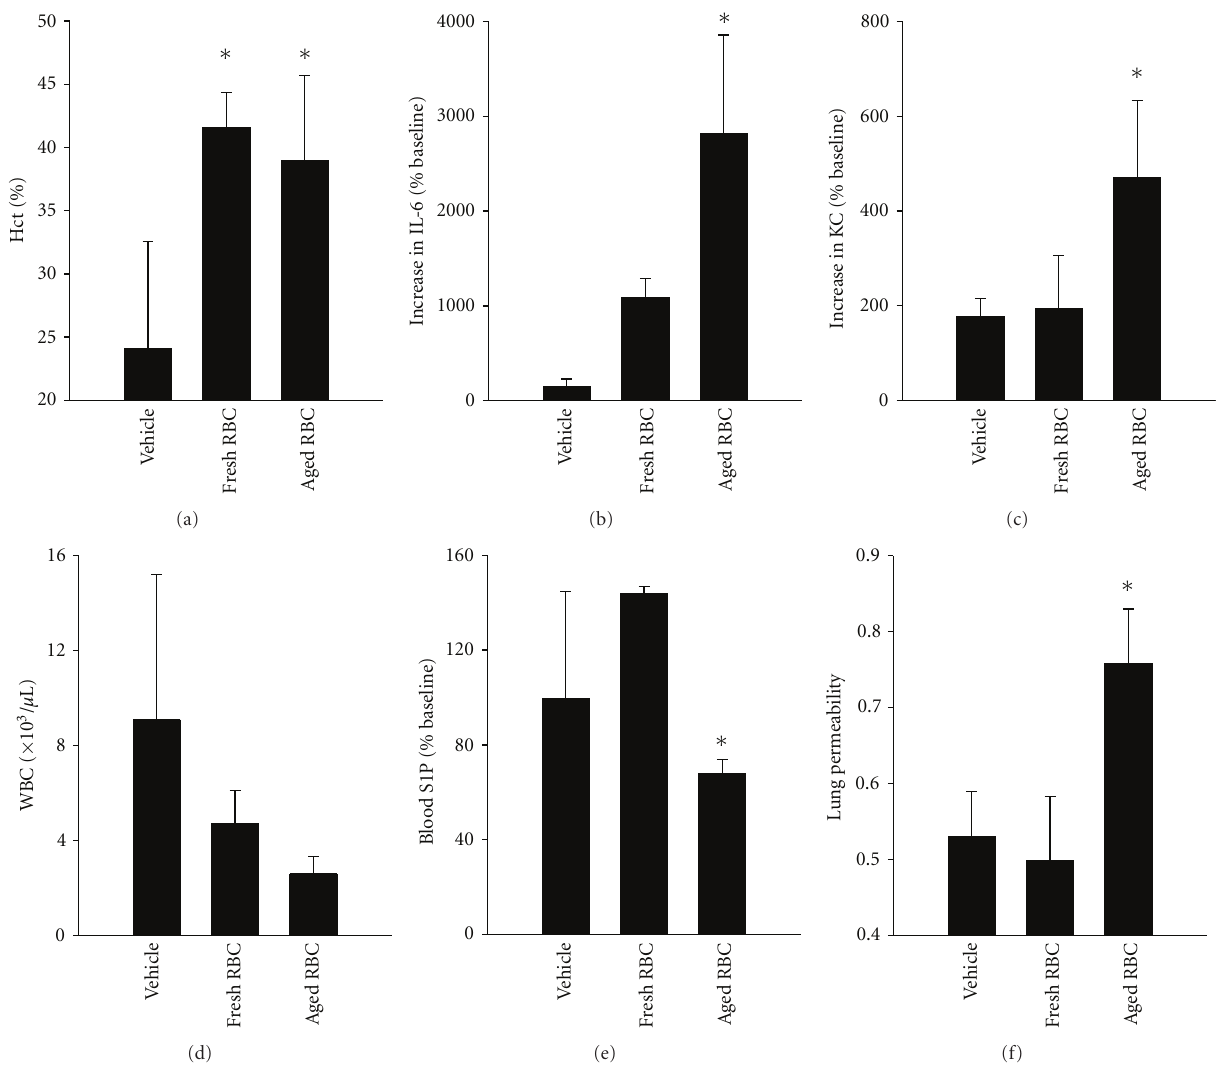
Figure 2: E ff ect of transfusion of fresh and aged RBC on systemic inflammation response and lung endothelial permeability. Twenty-four hours after major blood loss (0.02mL/gm), mice were administered 0.3 mL of PBS (“vehicle”), freshly isolated RBC at 50% Hct (“fresh RBC”), or RBC stored for > 14 days (“aged RBC”) at 50% Hct. Fortyeight hours after initial blood loss, (a) Hct, (b) plasma Il-6, (c) plasma KC, (d) white blood cell count (WBC), (e) blood S1P, and (f) lung endothelial permeability were measured. IL-6, KC, and S1P are reported as % of baseline (time 0). Results were analyzed by one-way ANOVA (Bonferroni correction), ∗ P < 0 . 05 versus